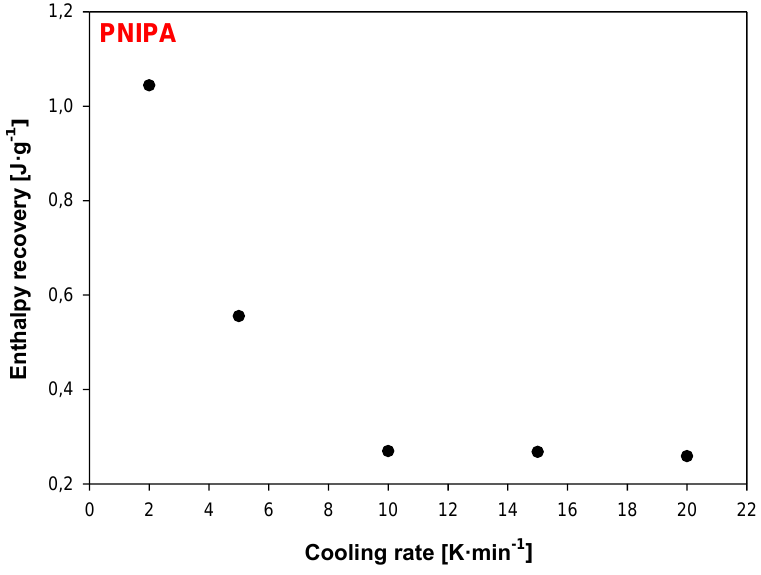
Figure 15. Enthalpy recovery versus di ff erent cooling rates obtained after the non-isothermal aging of amorphous PNIPA.